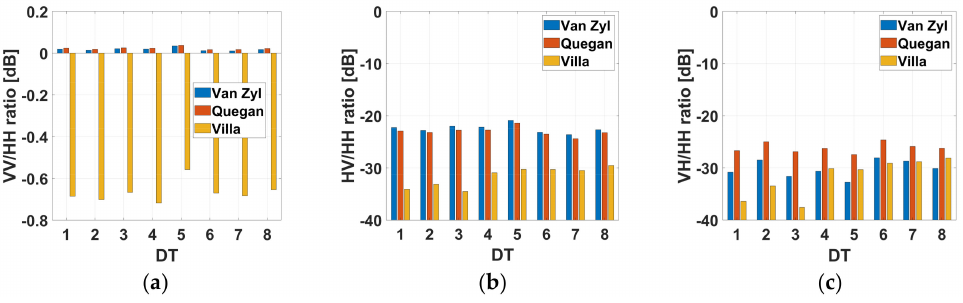
Figure 11. Ratio of ( a ) VV/HH, ( b ) HV/HH and ( c ) VH/HH polarizations of a corner reflector (CR) deployed on the real data after polarimetric calibration is performed by each method over the selected